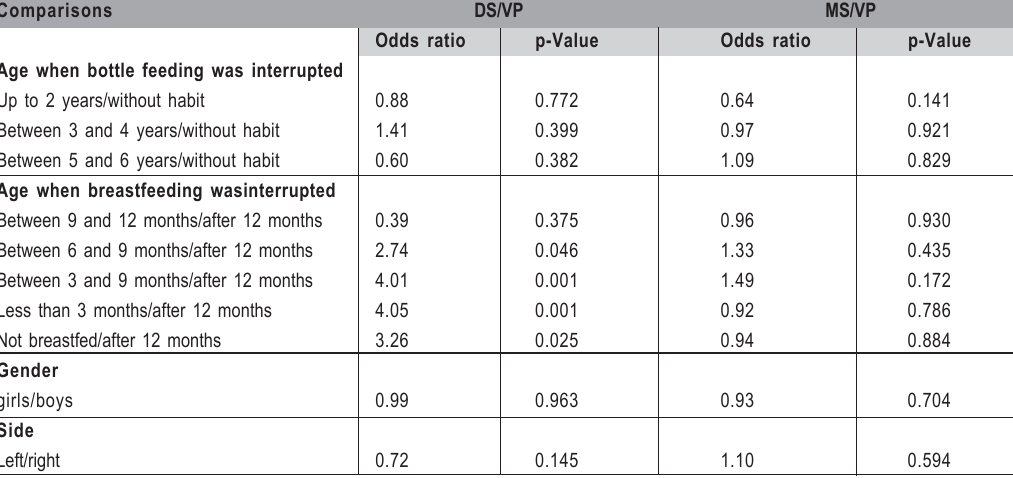
Table 5. Logistic regression model for the relationships of the distal surfaces of the primary second molars and all studied